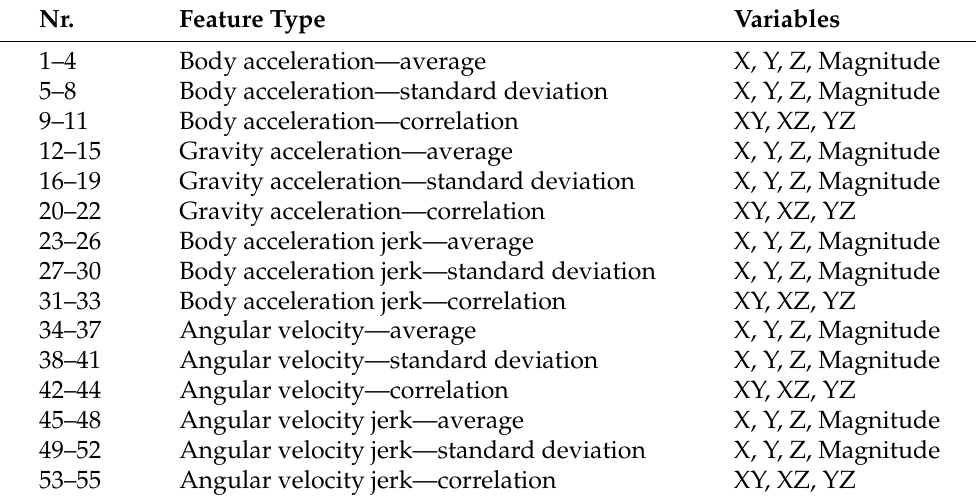
Table 2. The 55 features used for inference in the user